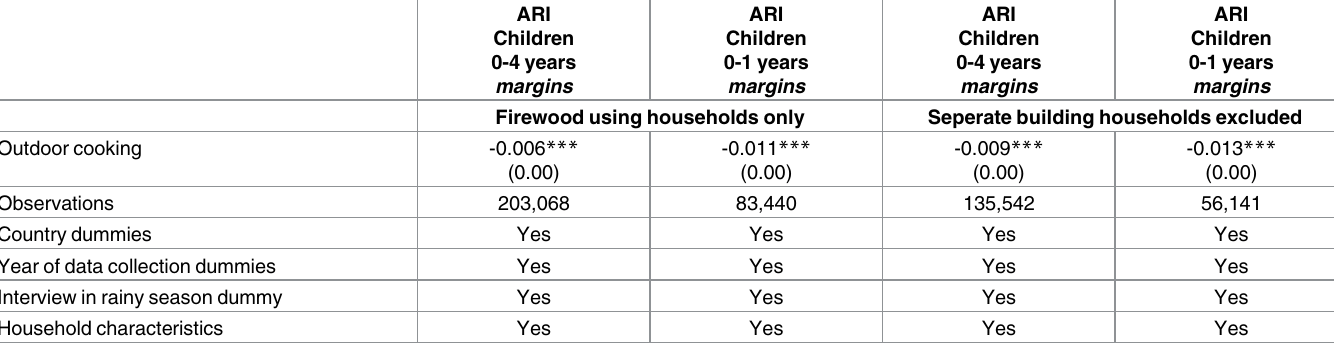
Table 2. ARI in the last 2 weeks preceding the survey in rural areaslimited to firewood cooking households and excluding separatebuilding cook- ing households a, b